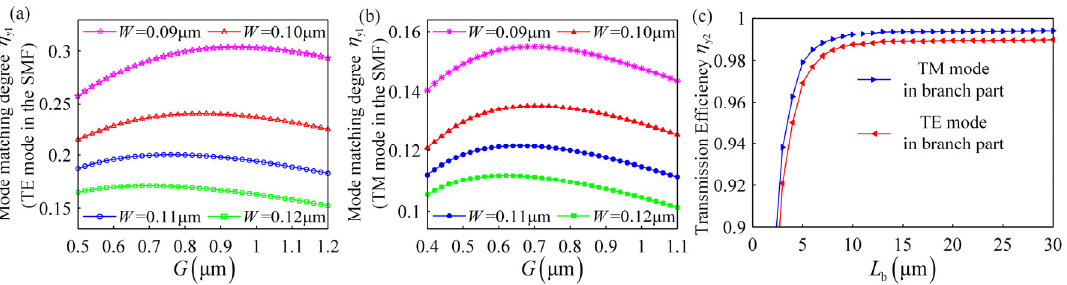
Figure 4. Influence of the width W and gap G on the mode matching degree η y1 when ( a ) TE mode or ( b ) TM mode in the SMF. ( c ) Influence of the length L b on the transmission e ffi ciency η y2 . Transmission e ffi ciency of the branch part ( η y2 ) is closely related to length of the branch part ( L b ),